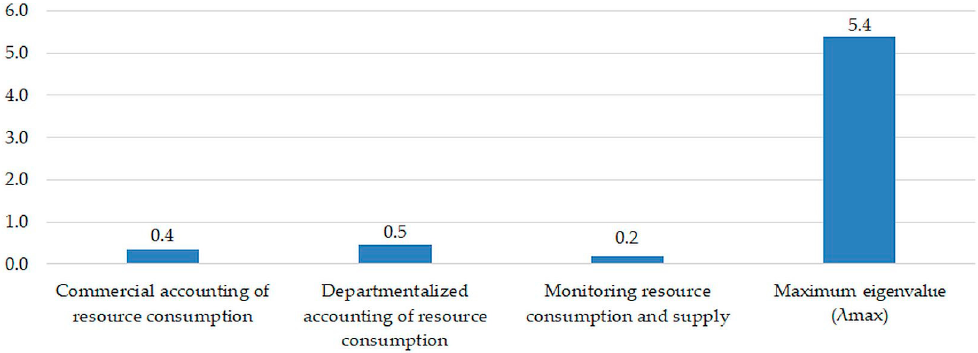
Figure 4. The degree of influence of the “Assessing the implementation of accounting and monitoring of resource consumption and supply” block at the “Factors” level.